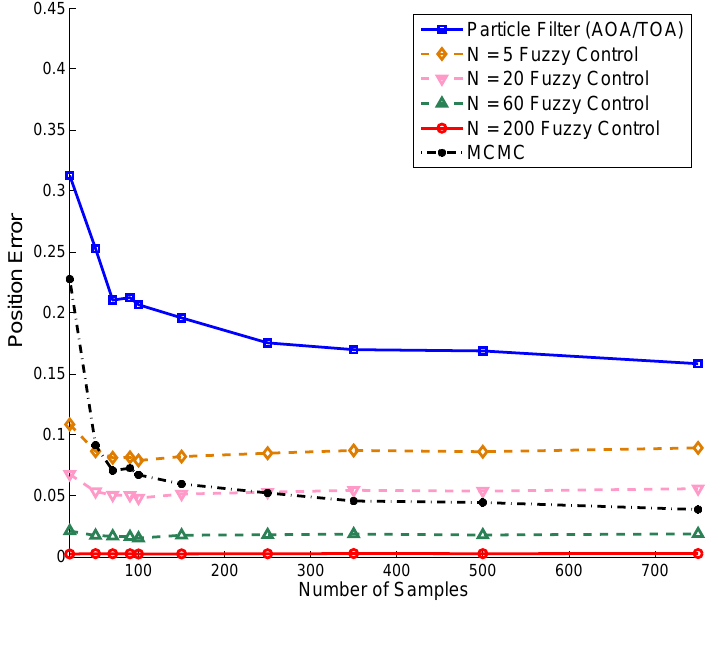
Figure 15. Performance comparison with varying the number of iterative for adaptive fuzzy control (using AOA/TOA